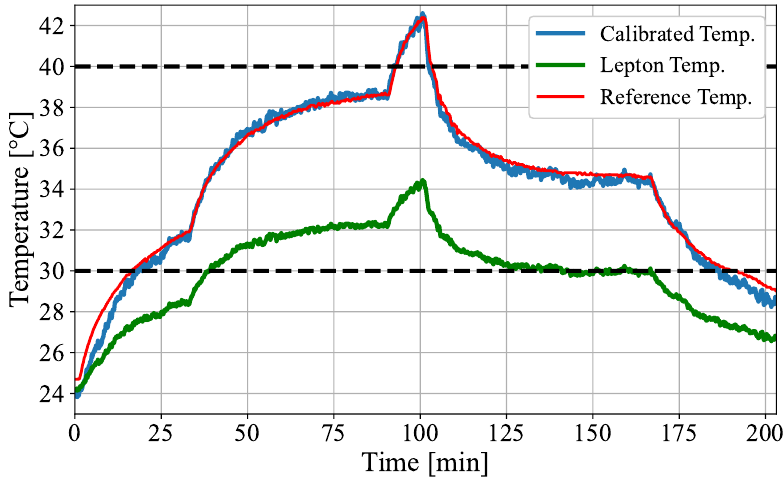
Figure 8. Validation measurement for temperature